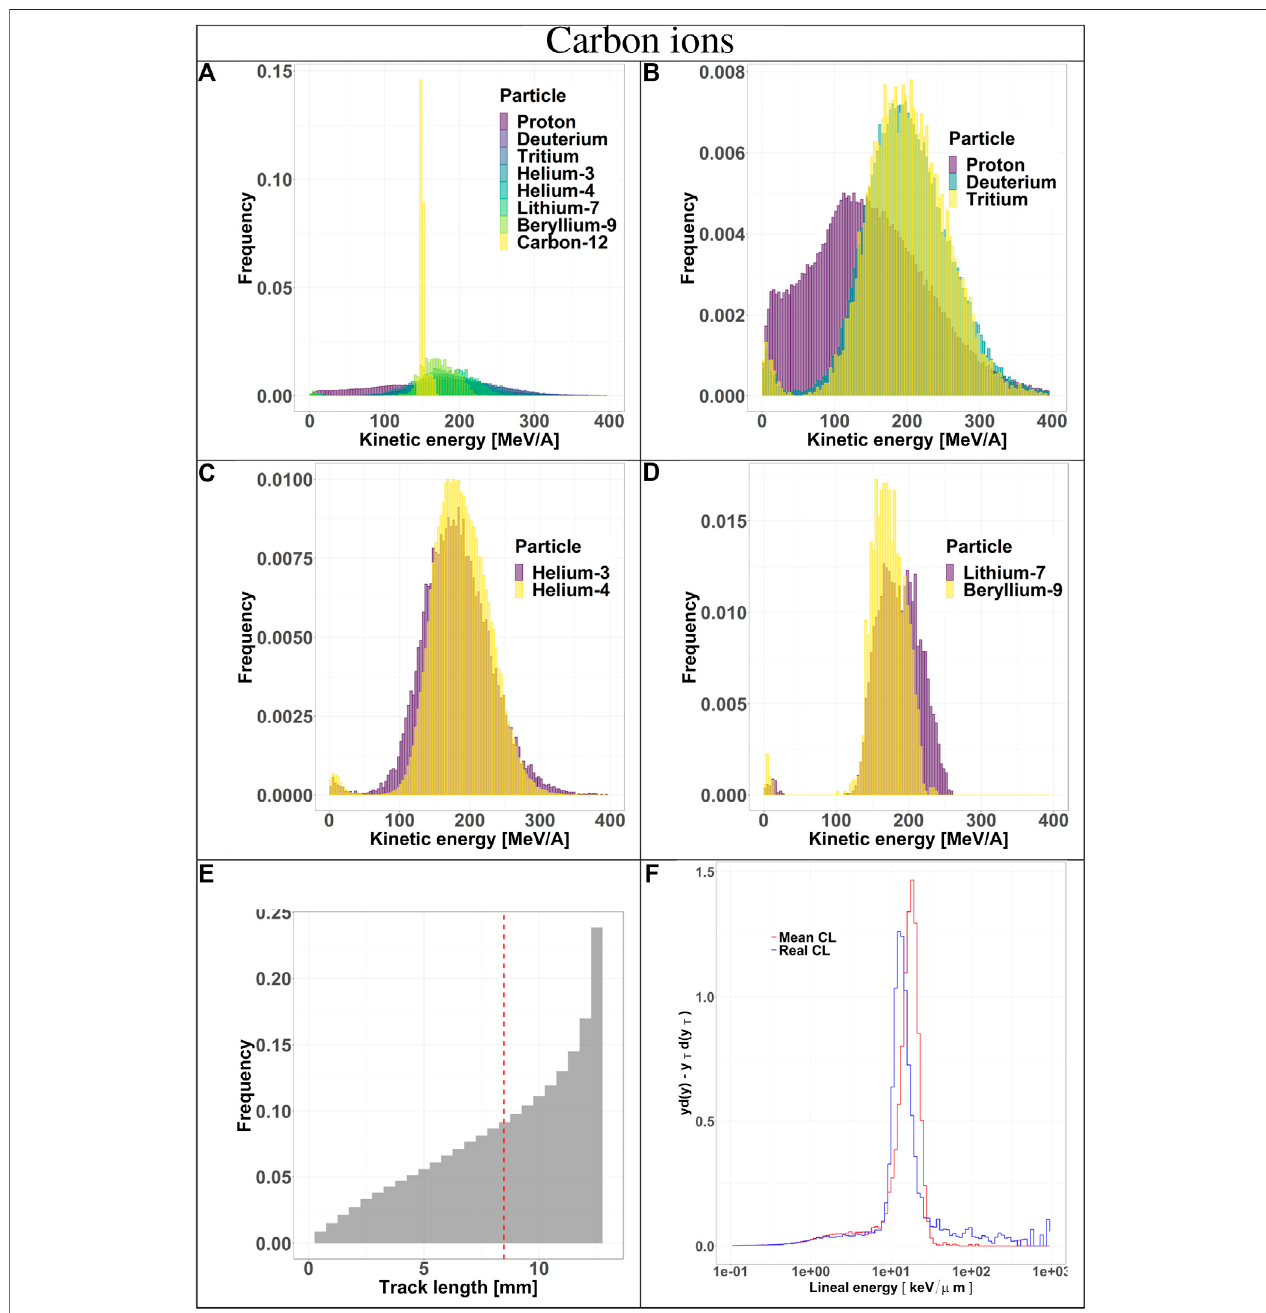
FIGURE 10 | Characterization of the particles lost by HDM when irradiated with 290 MeV/u carbon ions at a depth of 10.74 cm in water. Panels (A – D) : kinetic energy spectra of the most abundant components of the radiation fi eld including and excluding the primary ions. Panel (E) : track length distribution of all the particles detectedbytheTEPC.Themeanchordlengthat8.47 mmismarkedwithareddottedline.Panel (F) :microdosimetricyd(y)spectraobtainedwiththemeanchordlength approximation (red line) and microdosimetric y T d(y T ) spectra obtained using the real chord length values (blue line).